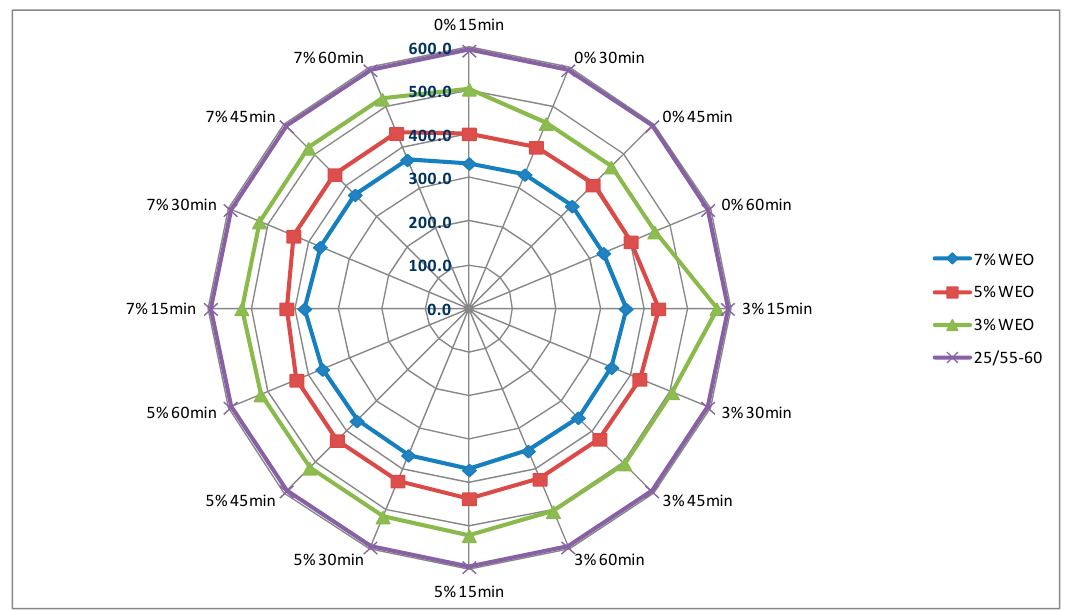
Figure 7. The results of dynamic viscosity tests for the 25/55-60 asphalt with the addition of WEO and clinoptilolite zeolite measured at 160 °C (mPa·s).